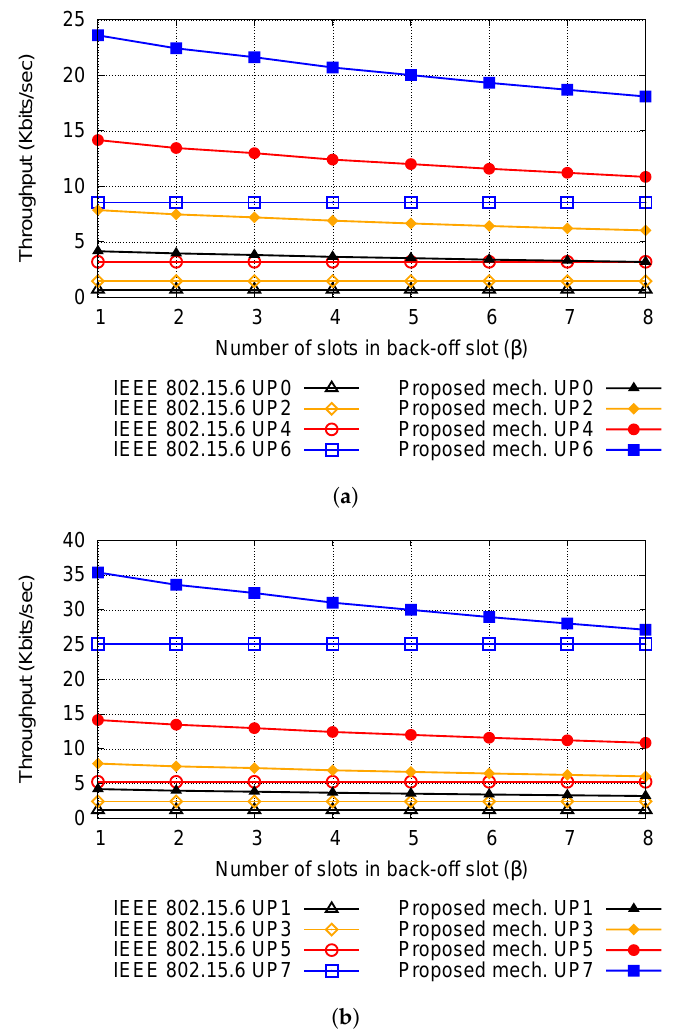
Figure 9. Throughput comparison of IEEE 802.15.6 and proposed mechanism for different UP (Scenario 2). ( a ) Throughput comparison for UP 0, 2, 4, and 6; ( b ) throughput comparison for UP 1, 3, 5, and